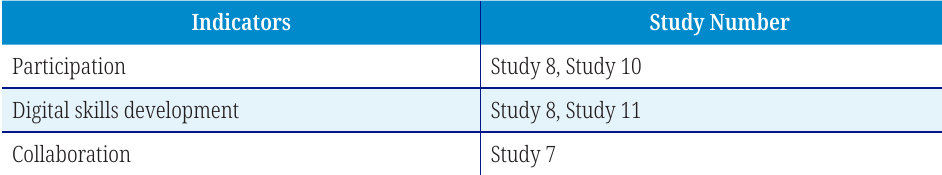
Table 6. Student behavioural engagement